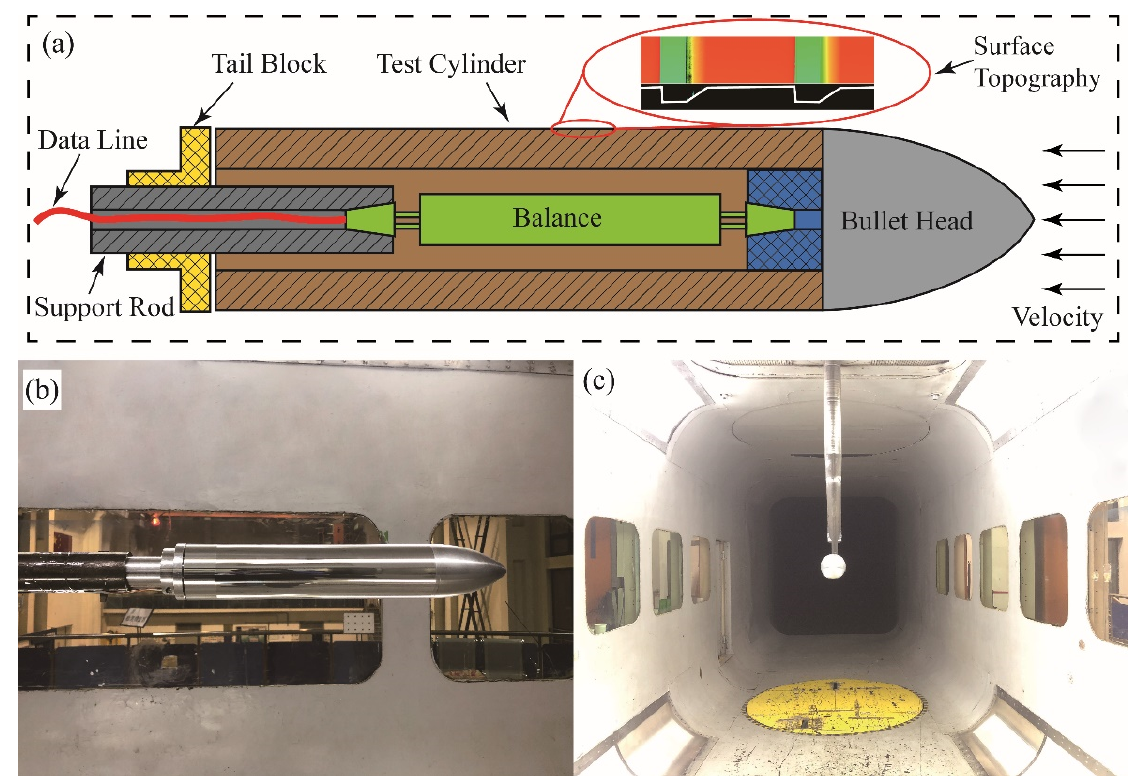
Figure 5. The experiment setup for the cylinder model: ( a ) the sketch of wind tunnel experiment for cylinder model; ( b ) and ( c ) are the pictures of the test model in the wind tunnel.